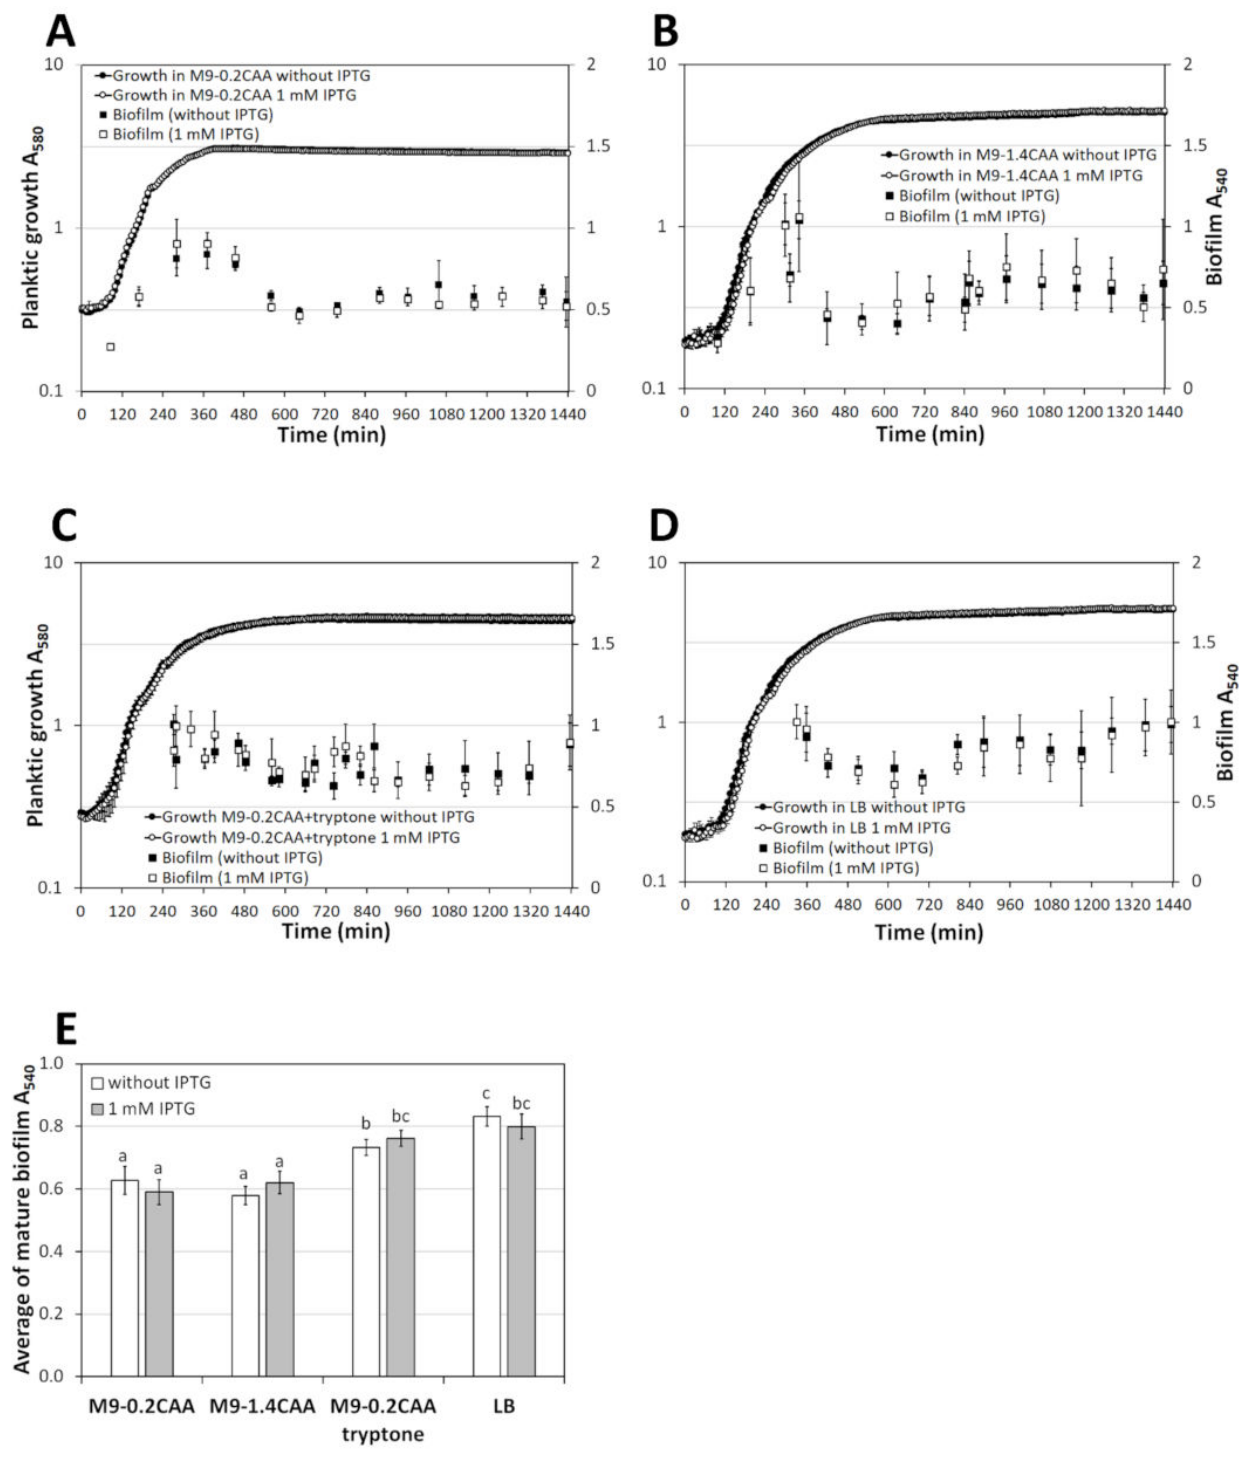
Figure 5. The biofilm dynamics and growth curves of P. putida wild type strain PSm grown in ( A ) M9-0.2CAA, ( B ) M9-1.4CAA, ( C ) M9-0.2CAA+tryptone, and ( D ) LB media with and